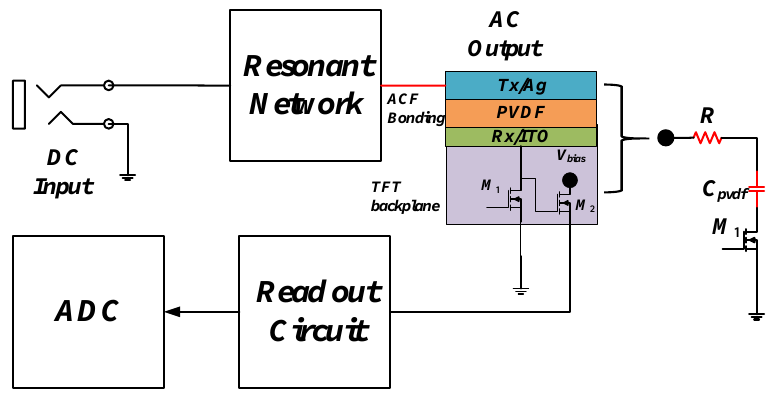
Figure 2. Tx and Rx circuit with a pixel.